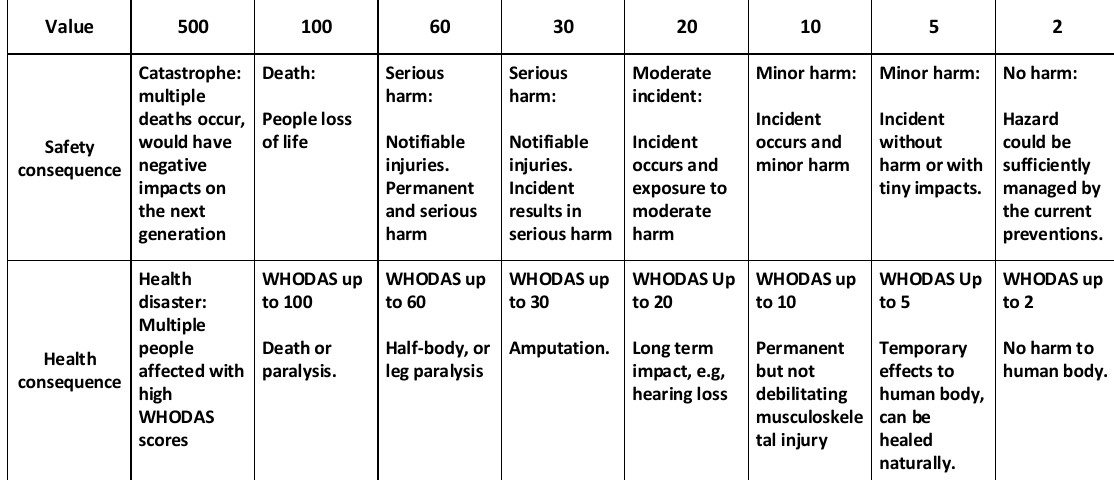
Table 2. WHODAS categories.